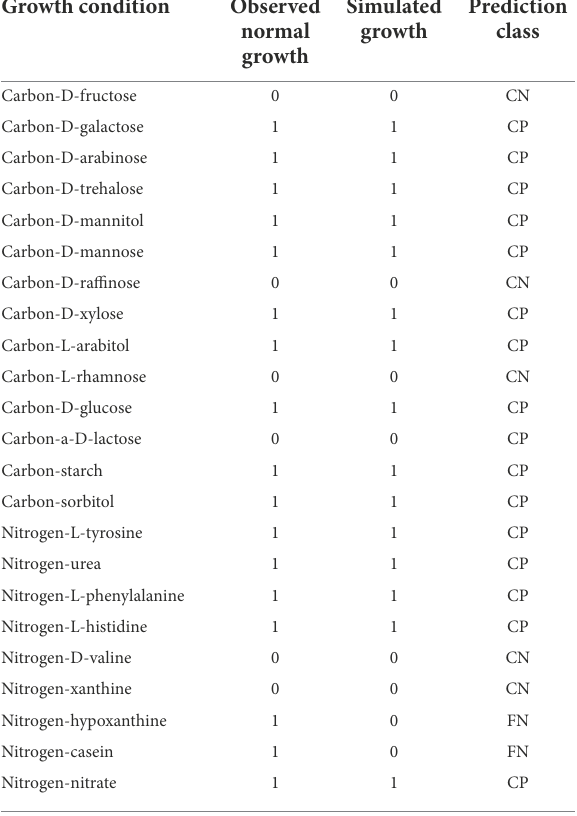
TABLE 3 Predicting the growth of model i SR1310 on different media based on phenotypic data. Growth